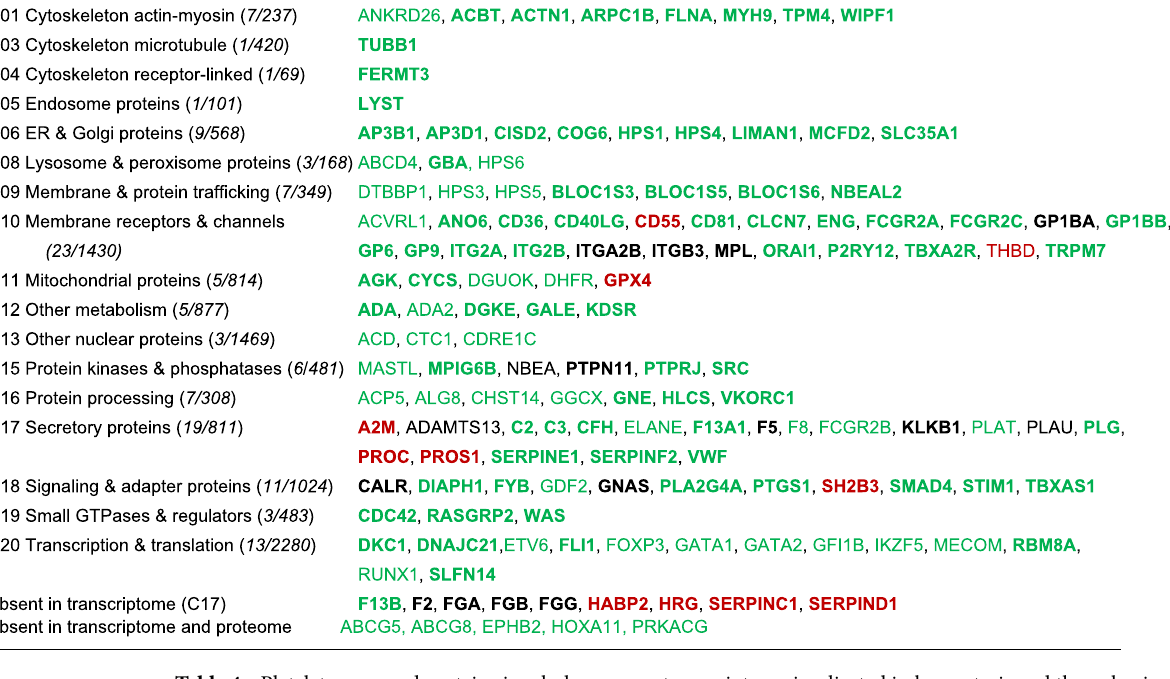
Table 4. Platelet-expressed proteins in whole-genome transcriptome implicated in hemostasis and thrombosis. Listed are per platelet function class genes expressed in the (non)identified platelet proteome, which according to recent OMIM, Bloodomics and overviews 23,34,35 in man contribute to bleeding, thrombocytopenia or thrombophilia. Coding as follows. Bold : identified in platelet proteome; green: bleeding or thrombocytopenia; red: thrombophilia; black: either